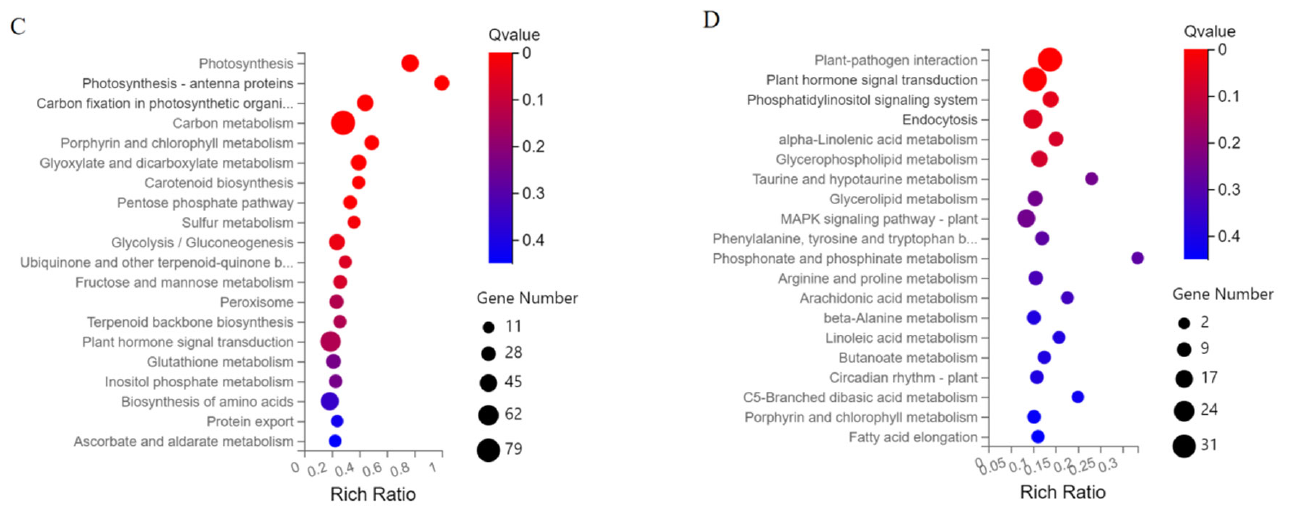
Figure 6. Gene co-expression network analysis by WGCNA. ( A ) Gene clustering tree and module division. ( B ) Module-sample association. The abscissa represents the samples; the ordinate repre- sents the modules. The variation from blue (low) to red (high) indicates the ranges of the DEGs. ( C ) Enrichment in KEGG pathways of DEGs in the dark red module. ( D ) Enrichment in KEGG pathways of DEGs in the yellow module.